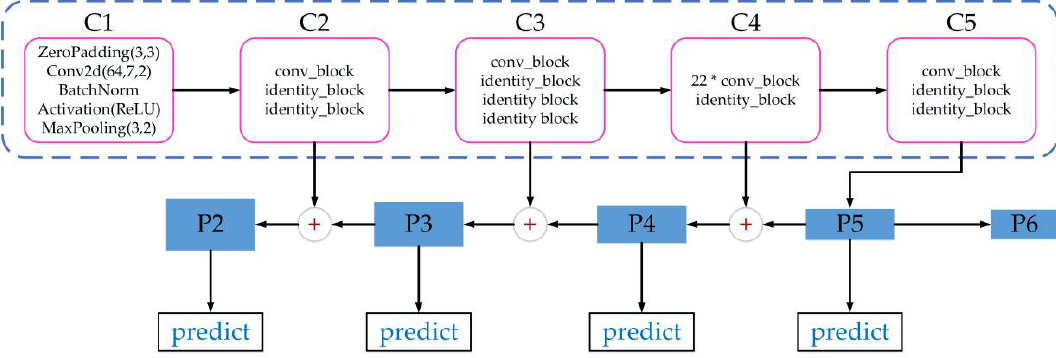
Figure 3. Feature pyramid networks (FPN) structure diagram.